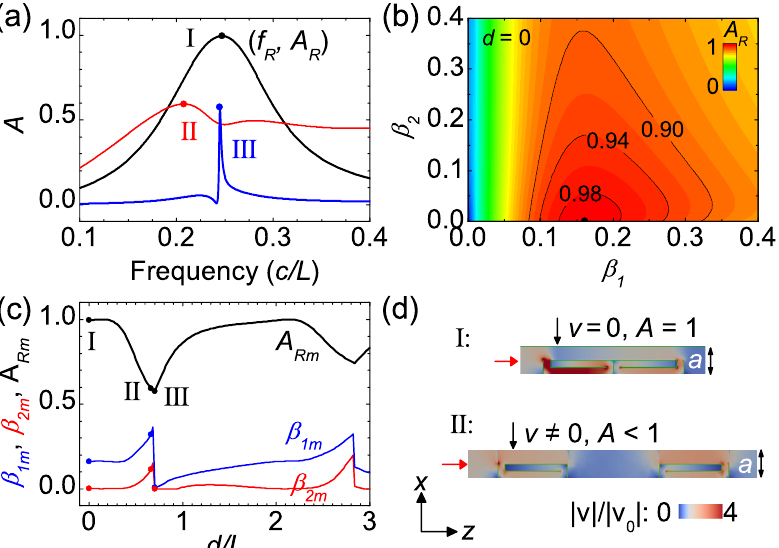
Figure 2. Demonstration of perfect sound absorption in bilayer labyrinthine metasurfaces with open area ratio p o = 0.5 . ( a ) Calculated sound absorption spectra for structure I with d = 0, β 1 = 0.161, and β 2 = 0 (black curve), structure II with d = 0.66 L , β 1 = 0.321 , and β 2 = 0.115 (red curve), and structure III with d = 0.70 L , β 1 = 0.0073 , and β 2 = 0 (blue curve). The absorption approaches a maximum A Rm at resonant frequency f R . ( b ) A R as a function of β 1 and β 2 for bilayer metasurfaces with d = 0 . A R reaches a maximum A Rm at optimal losses ( β 1 = β 1 m , β 2 = β 2 m ). ( c ) β 1 m , β 2 m , and A Rm as a function of layer spacing d . ( d ) Simulated distributions